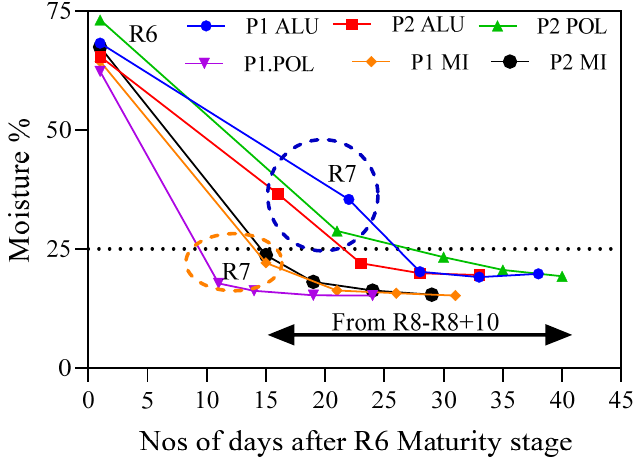
Figure 7. Moisture content of different harvesting maturity stages (R6, R7, R8, R8 + 5 and R8 + 10) at different production environments.